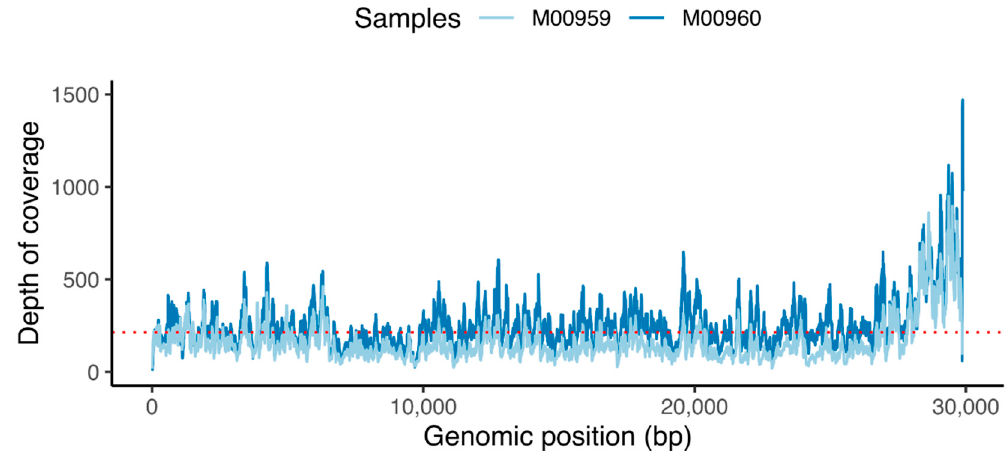
Figure 4. Depth of coverage. Red dotted line indicates the average read coverage (214 × ). Table 1. SNPs detected in the newly sequenced genome using the VCFtools.